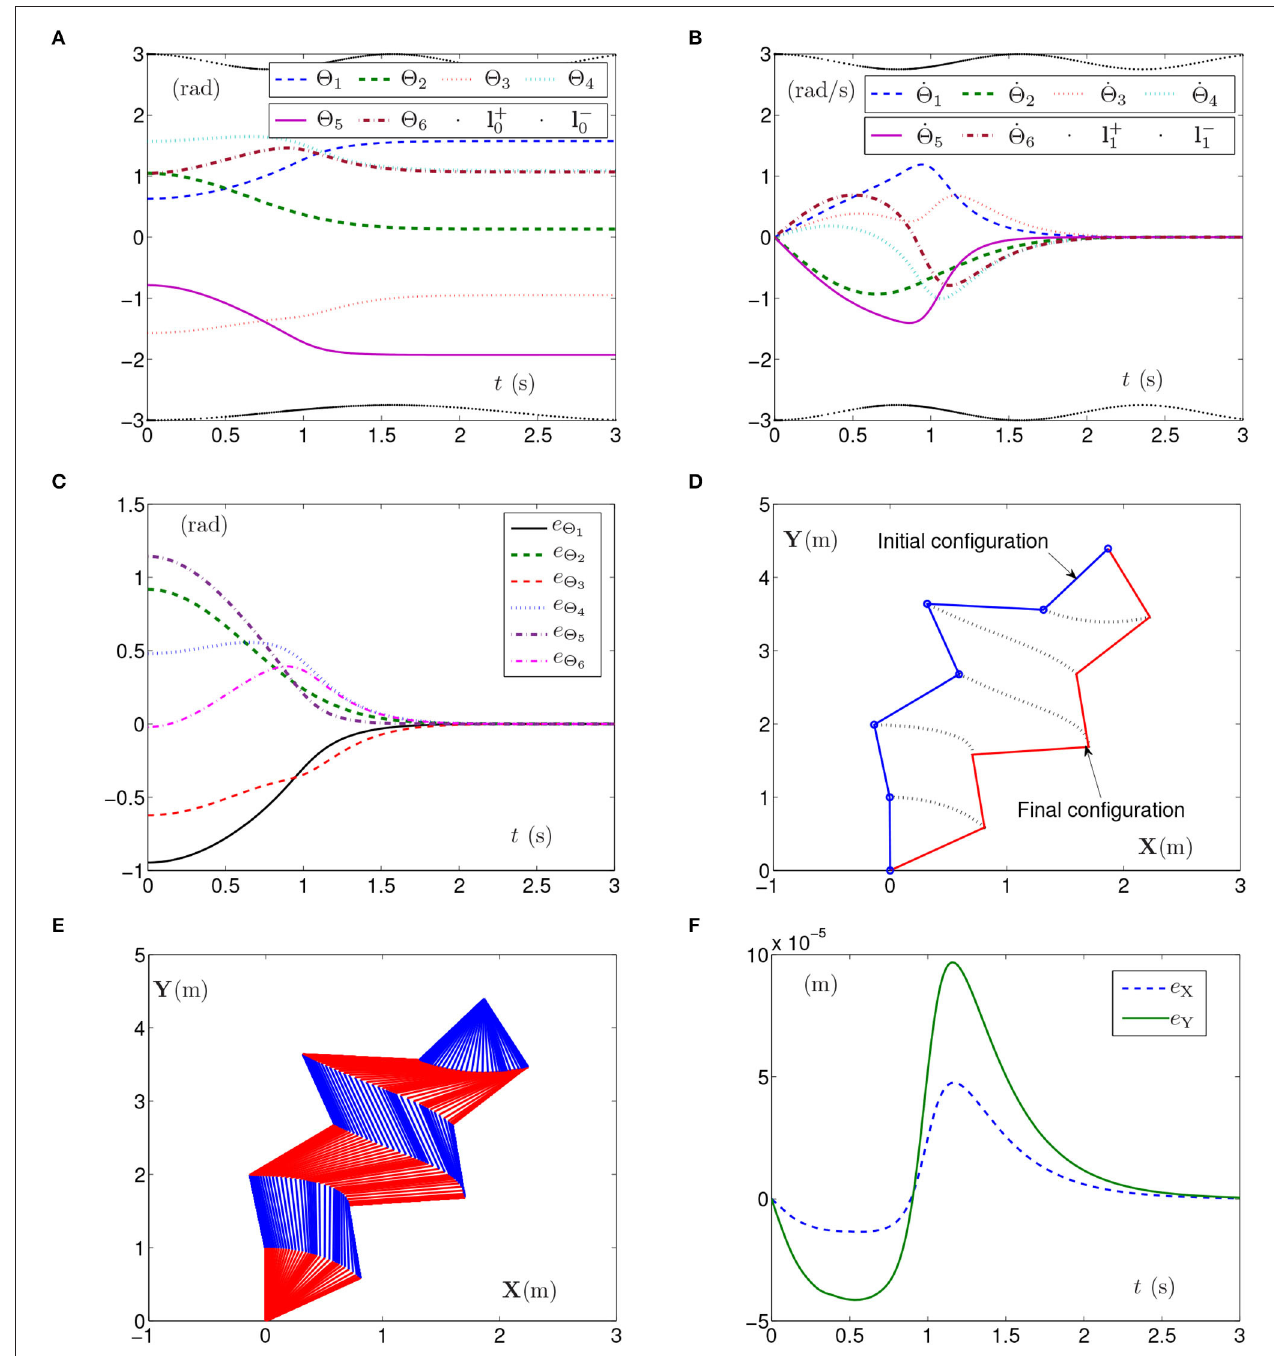
FIGURE 1 | Synthesized results of the planar manipulator using SMCSvZ with time-varying physical limits satisfied in case A. (A) Profiles of joint angles. (B) Profiles of joint-angle velocities. (C) Profiles of joint-angle errors. (D) Profiles of initial and final manipulator positions. (E) Profiles of the planar manipulator. (F) Profiles of end-effector position